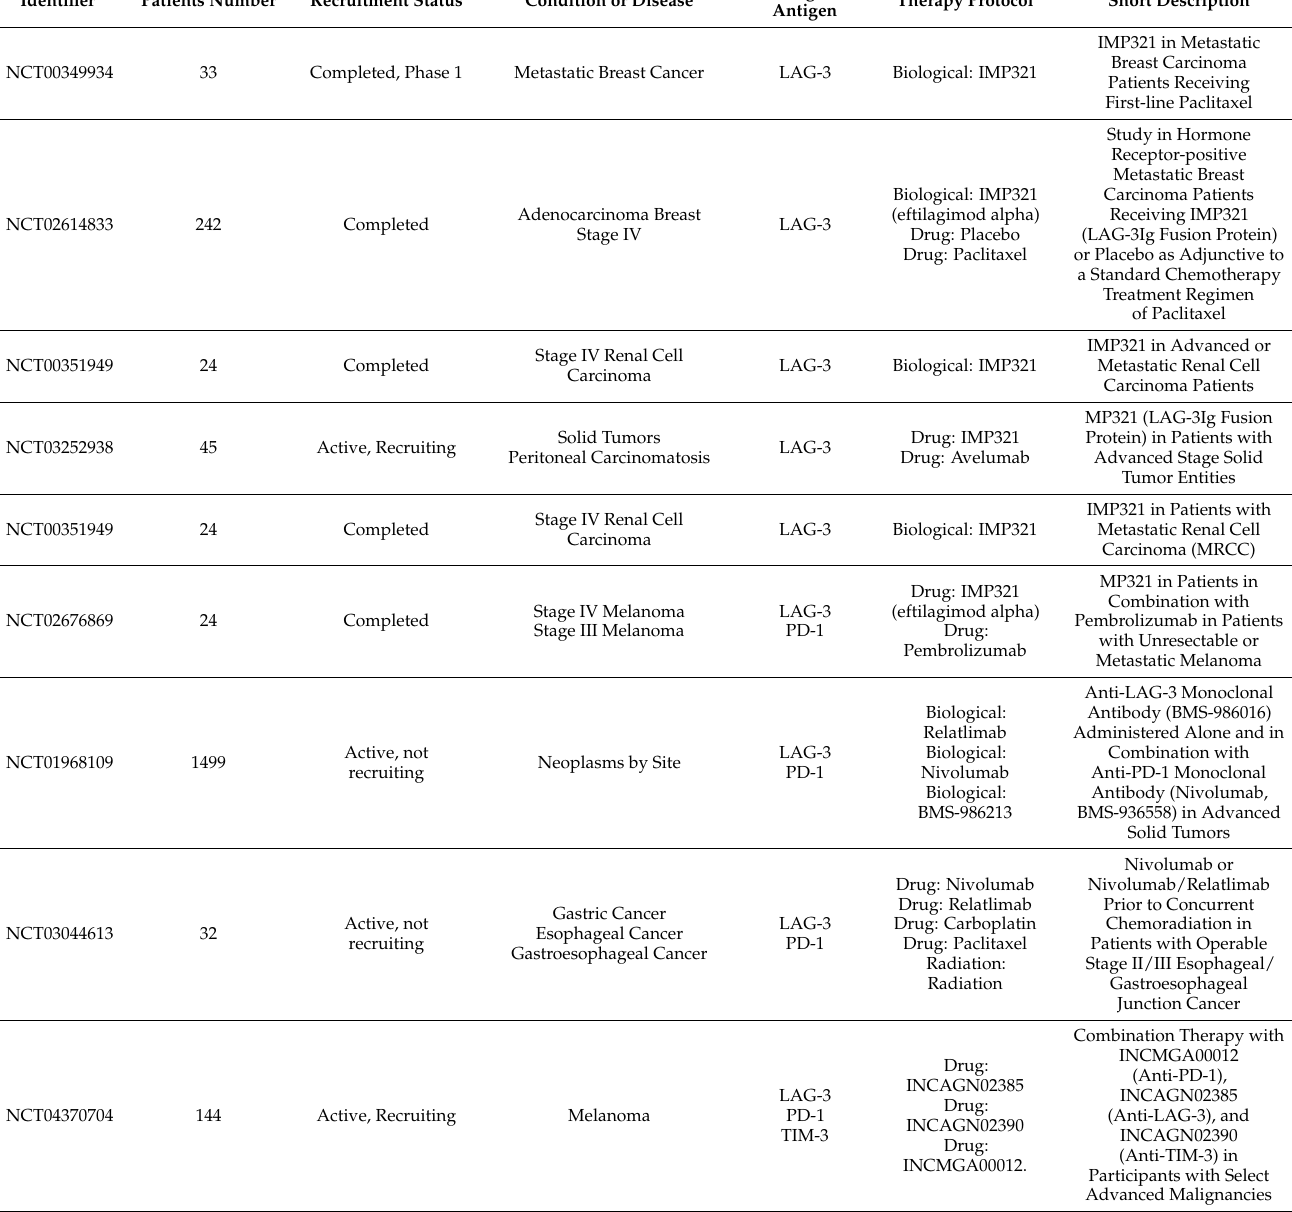
Table 3. Examples of Clinical Trials involving Soluble LAG-3-Ig fusion